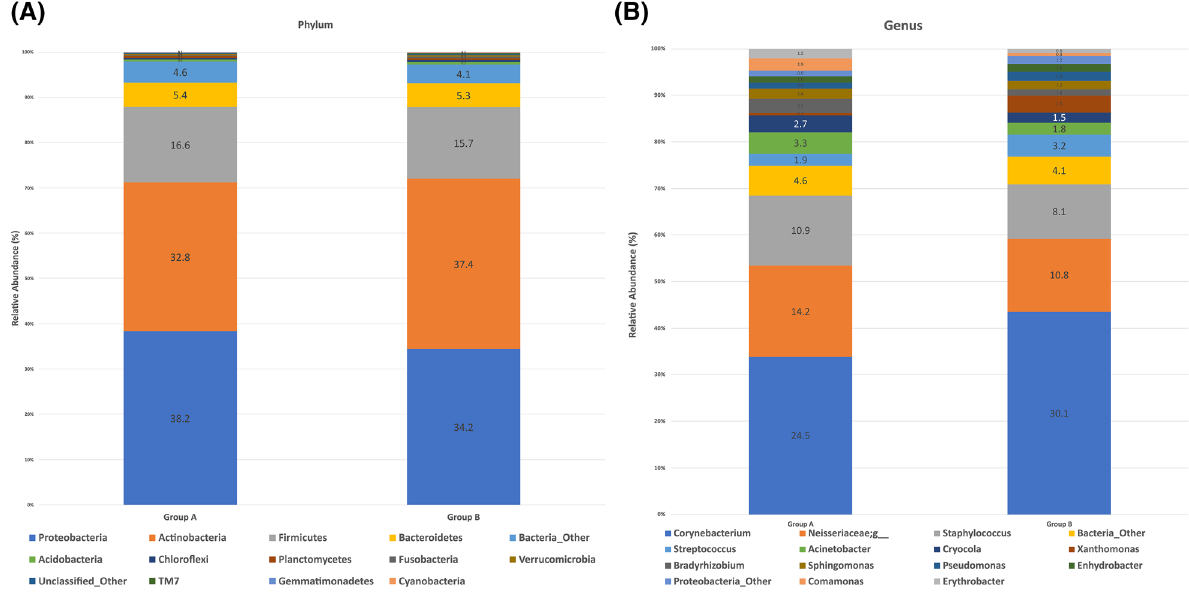
Figure 3. Core microbiome and taxonomic relative abundance of the two groups according to phyla ( A ) and genera ( B ).